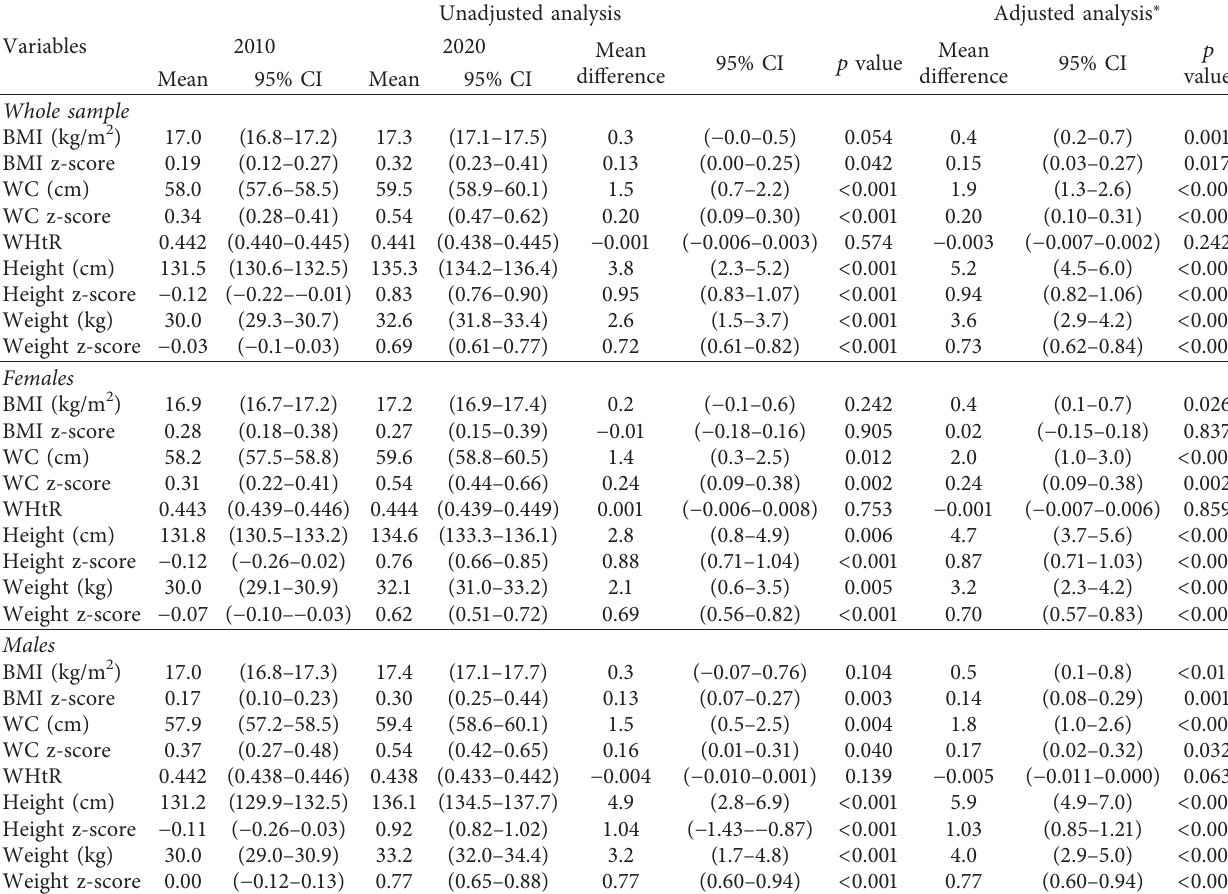
Table 2: Means of the anthropometric parameters of study participants between 2010 and